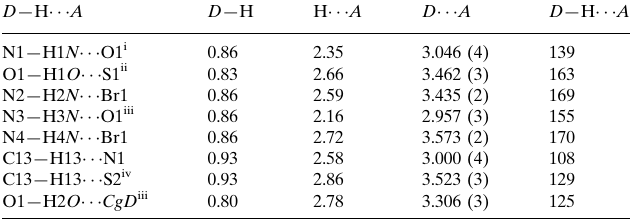
Hydrogen-bond geometry (A˚ , (cid:3)